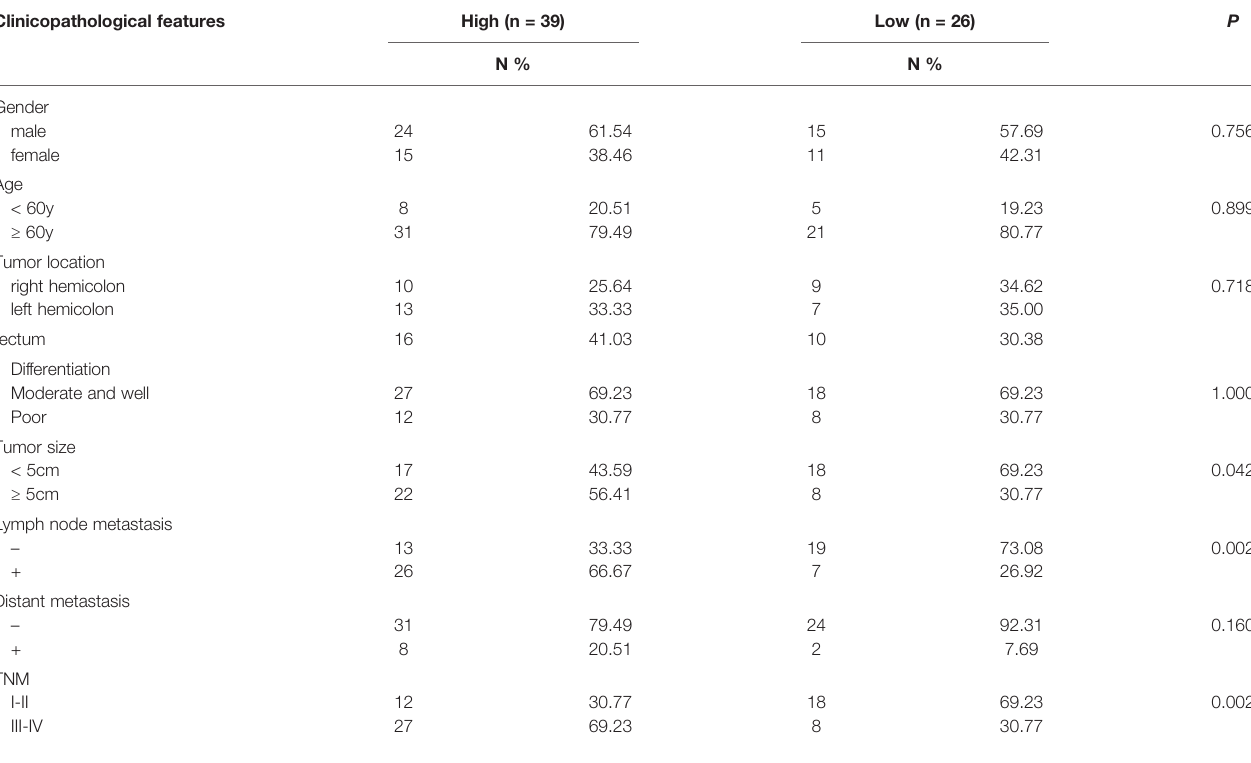
TABLE 2 | Associations between ECM1 expression and CRC patient clinicopathological features. Clinicopathological